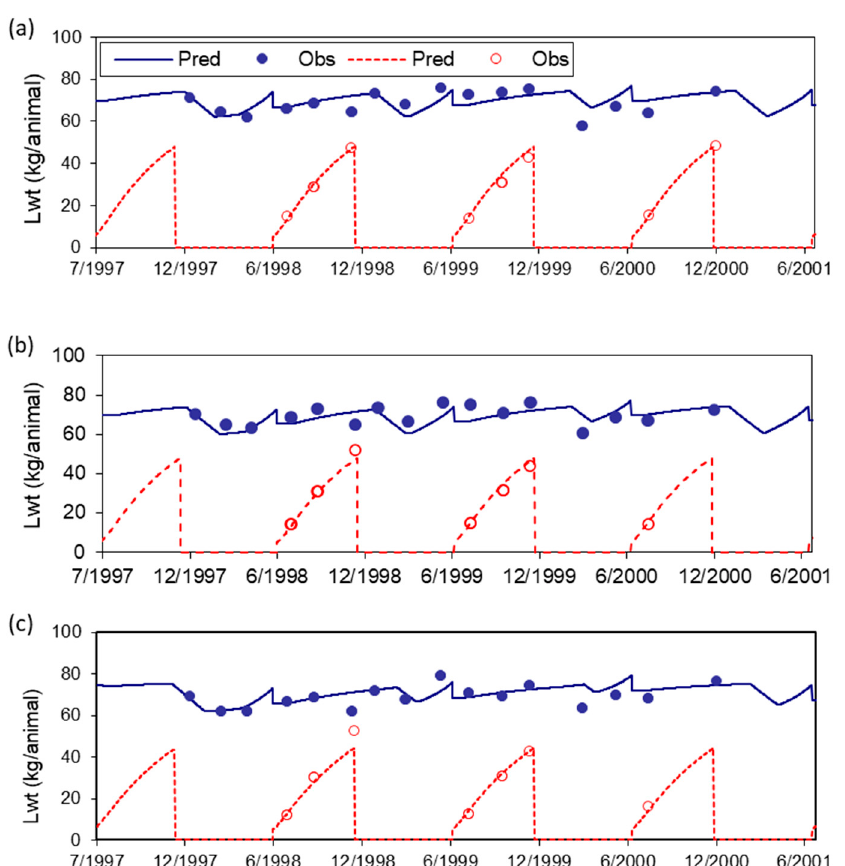
Figure 7. Observed and predicted average daily liveweight (Lwt; kg/animal) for ewes and lambs in the ( a ) MH, ( b ) MM and ( c ) ML systems.